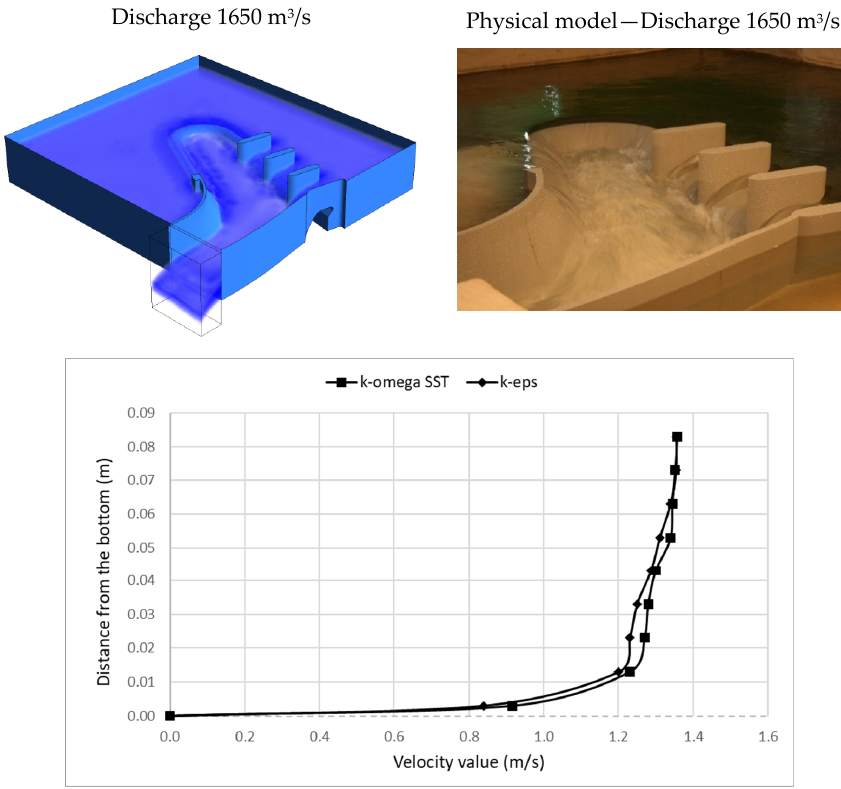
Figure 12. Comparison between the hydrodynamics resulting from the numerical model (for both the tested turbulence models) and the physical model.